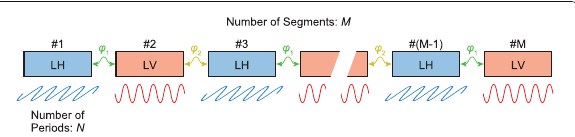
Fig. 2 Schematic layout of SCU composed of LH and LV IDs. The blue and red sinusoidal lines represent the emitted electric field from the LH and LV IDs, respectively. The phase of the odd and even number ID segments are shifted by ϕ 1 and ϕ 2